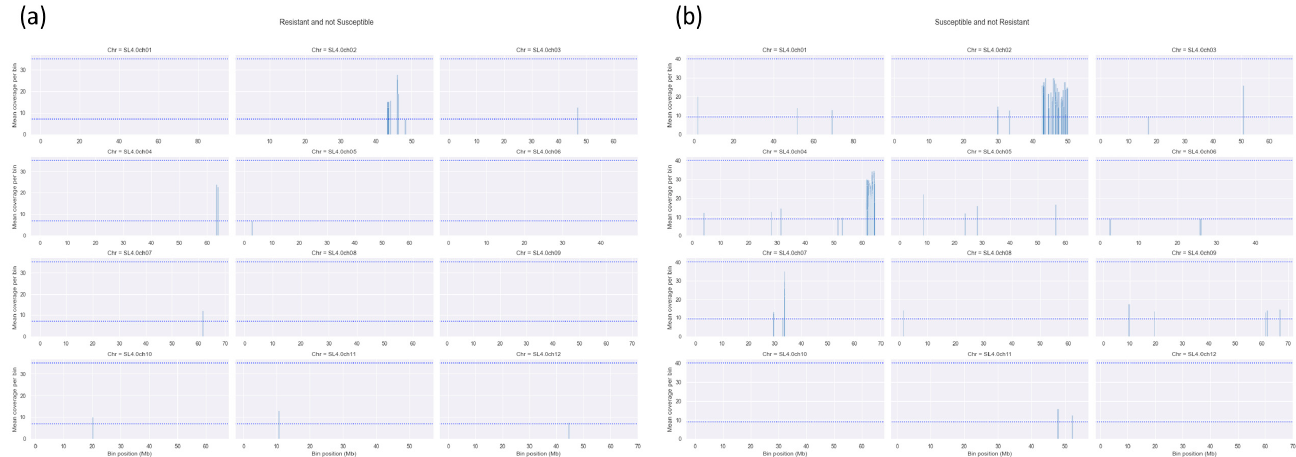
Figure 3. Loci linked to tolerance and susceptibility to Cm mapped on chromosomes 2 and 4 of tomato. Density graphs of unique k-mers mapped to bins equal to k-mer size on the tomato ( S. lycopersicum ) reference genome ITAG 4.0. ( a ) Blue vertical lines indicate loci associated with tolerance, ( b ) blue vertical lined indicate loci associated with susceptibility.